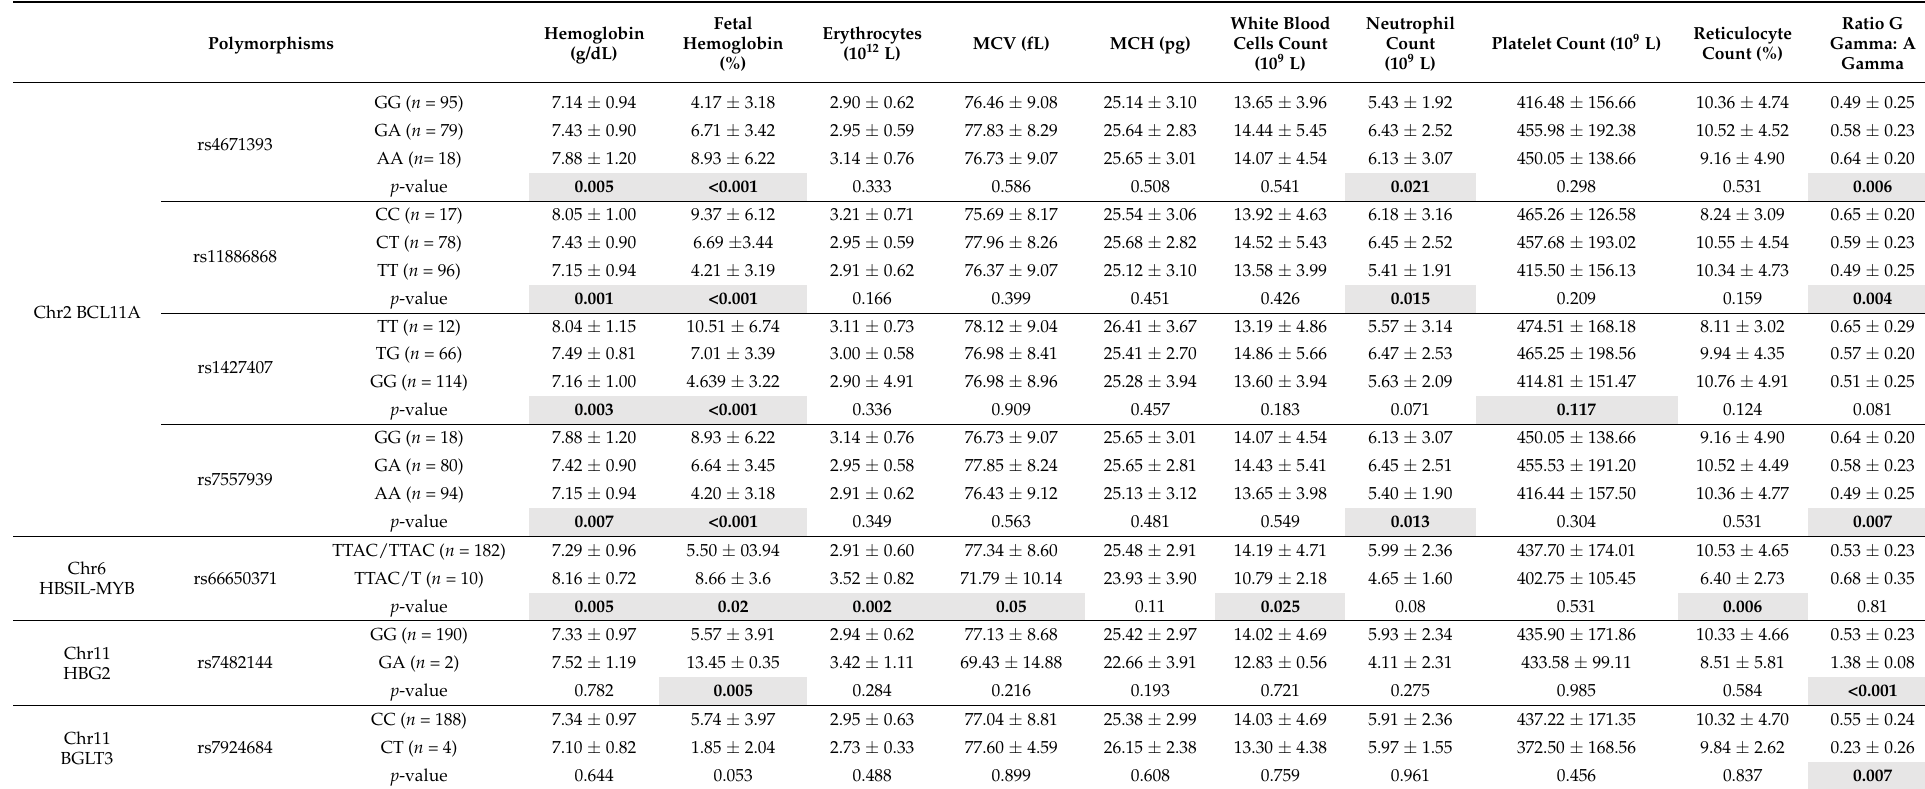
Table 2. Clinical and hematological variables associated with different polymorphisms. Statistical analysis was performed by one-way ANOVA. Bold values with grey background denote statistical significance at the p < 0.05